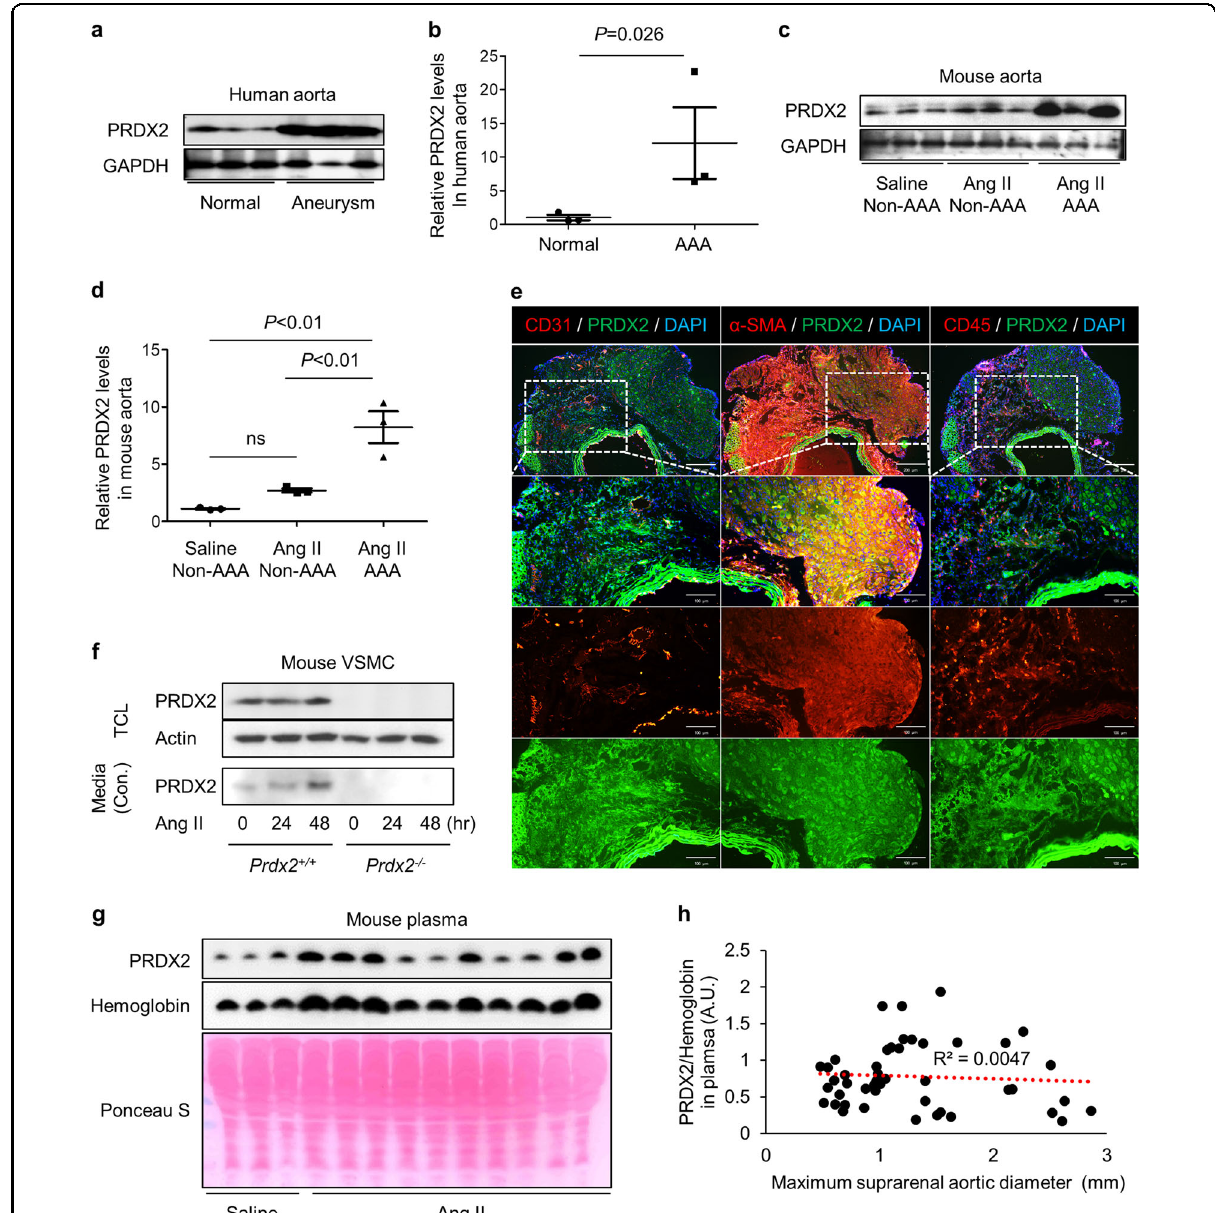
Fig. 1 PRDX2 is increased in the aneurysmal aortas of humans and mice. a Immunoblotting analysis and b quanti fi cation of PRDX2 in healthy and aneurysmal aortas obtained from patients ( n = 3). Data are presented as the mean ± SEM (two ‐ tailed Student ’ s t test). c Immunoblotting analysis and d quanti fi cation of PRDX2 in abdominal aortas obtained from C57BL/6 mice infused with saline (non-AAA) and Ang II (non-AAA and AAA; n = 3). Data are presented as the mean ± SEM (one-way ANOVA). e Representative immunostaining images of PRDX2 (green) with CD31 (red, left), α -SMA (red, middle), or CD45 (red, right) on AAA. Cross-sectional low magni fi cation images (top; scale bar, 200 µm) with higher magni fi cation of the boxed area (lines 2 – 4; scale bar, 100 µm). Nuclei were stained with DAPI. f Immunoblotting analysis of PRDX2 in total cell lysates and concentrated culture media of primary VSMCs isolated from Prdx2 + / + and Prdx2 − / − mice. Ang II was administered to primary VSMCs during the indicated times. g Immunoblotting analysis of PRDX2 in plasma from mice infused with saline or Ang II. Hemoglobin was used for the normalization of PRDX2 levels in plasma obtained from RBC lysis. Ponceau S staining was used as a loading control. h Scatter plot and coef fi cient of determination between PRDX2/ hemoglobin in mouse plasma and the maximum suprarenal aortic diameter of mice infused saline or Ang